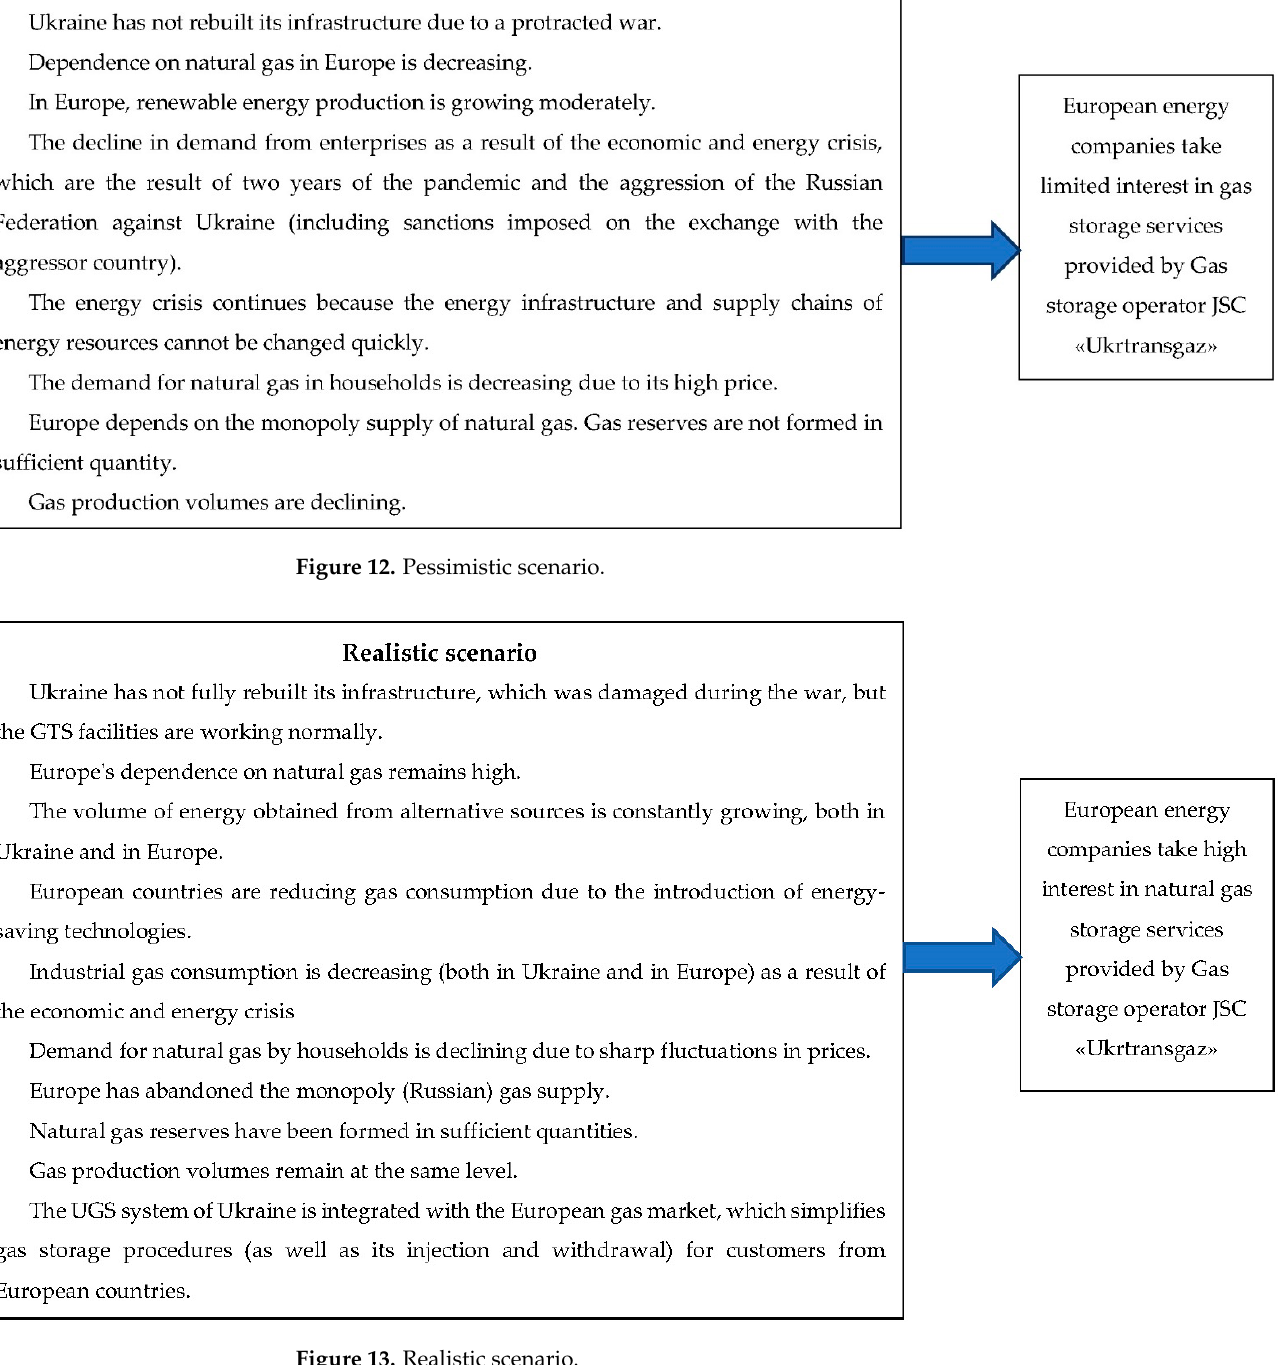
Figure 13. Realistic scenario.